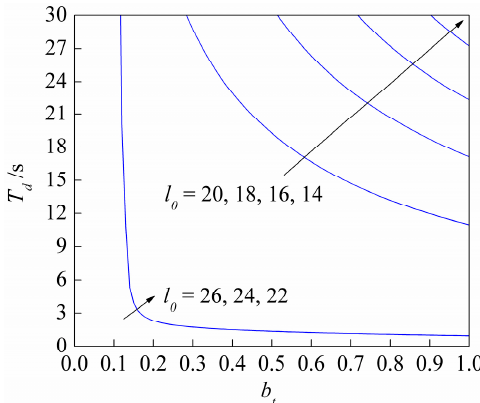
Figure 4. Effect of air chamber height, l 0 (m), on the system stability [56].